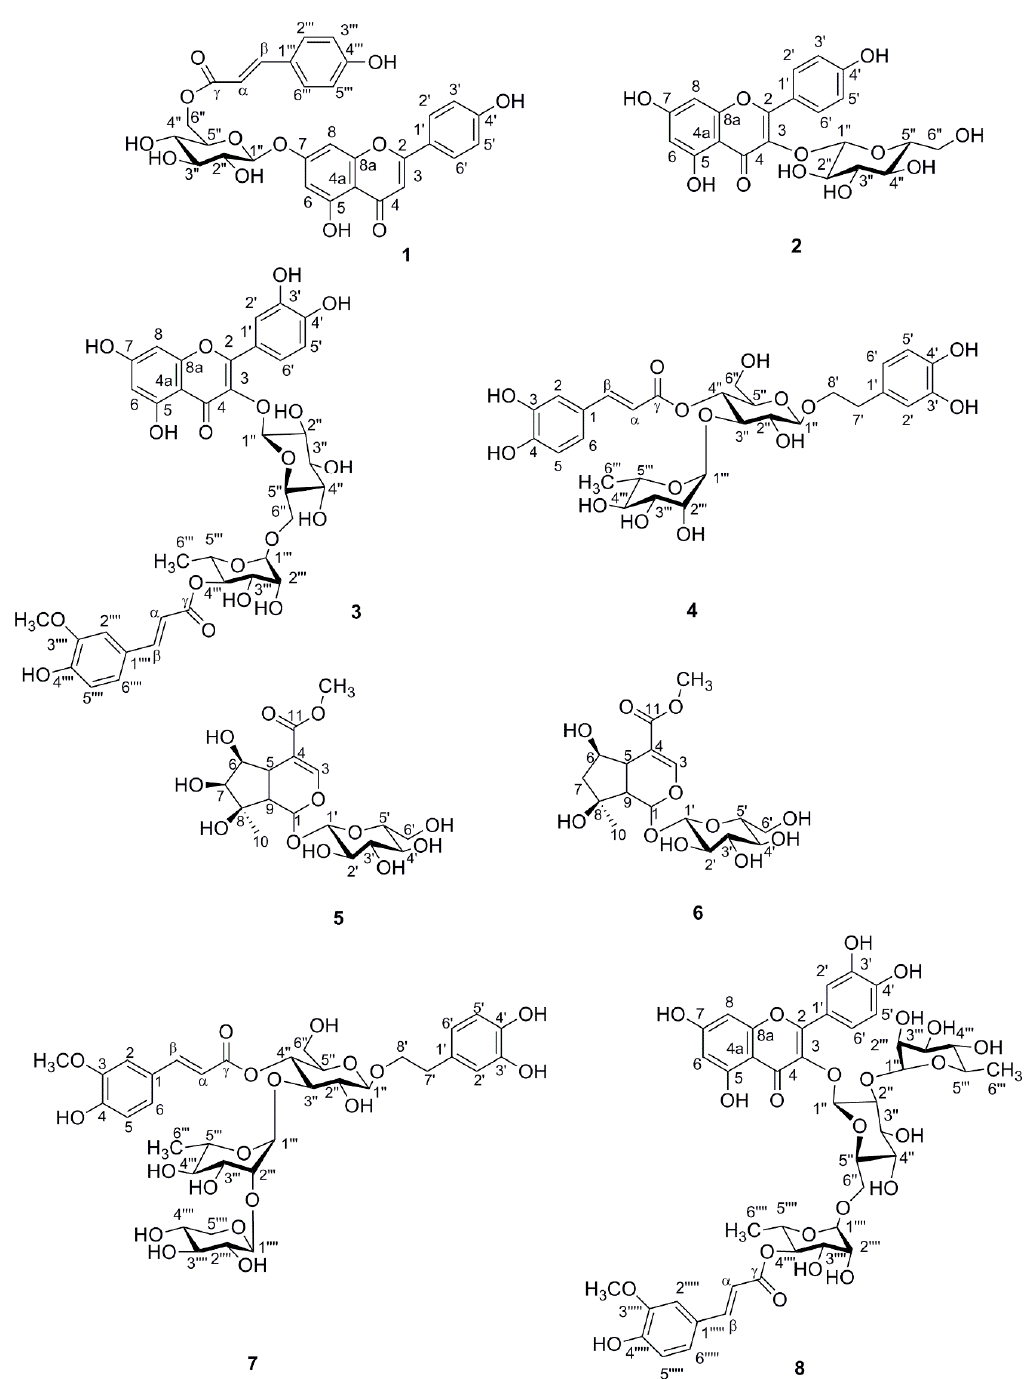
Figure 1. Structures of isolated compounds.